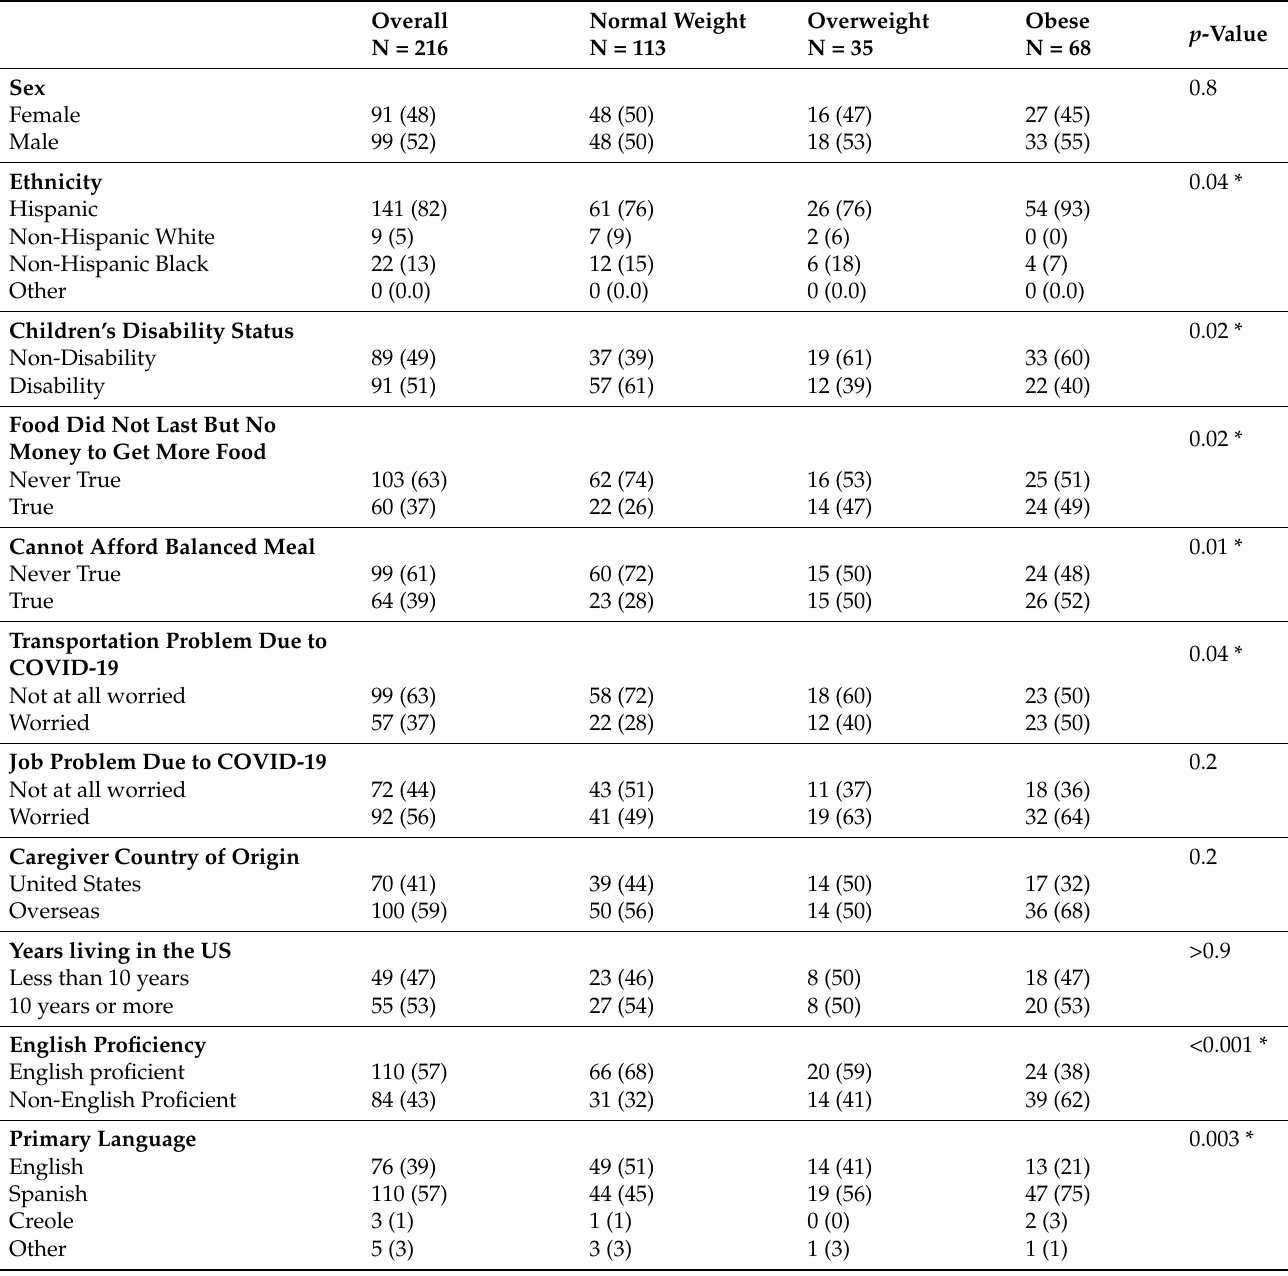
Table 2. Participant Descriptive and COVID-19 Pandemic-Related Challenges by Weight